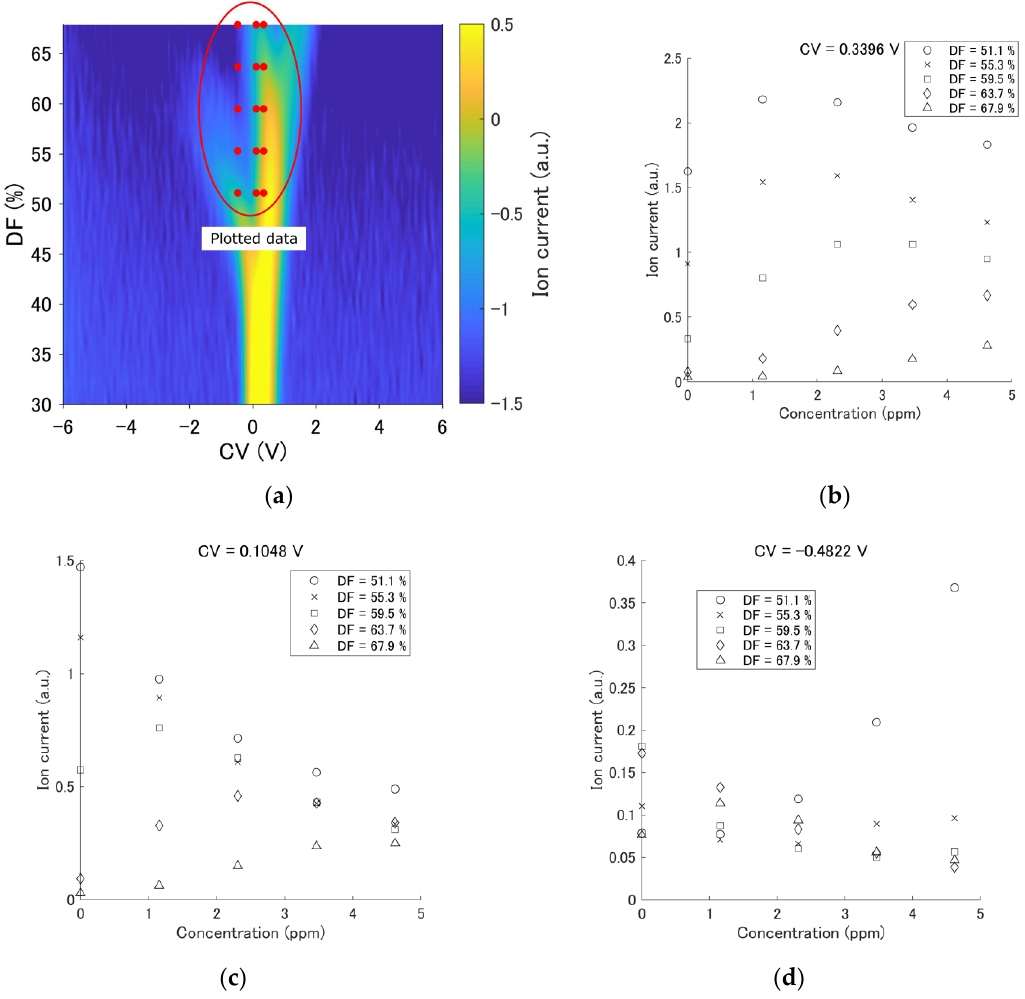
Figure 4. An example of a ternary gas mixture. The concentration of acetone was changed from 0 ppm to 4.6 ppm, and the concentrations of other gases were fixed at 6.1 ppm. DFs of 51.1, 55.3, 59.5, 63.7, and 67.9% were selected. ( a ) The measurement results indicated that the mixture included 4.6 ppm acetone, 6.1 ppm ethanol, and 6.1 ppm diethyl ether. The red circle indicates the portion of plotted data in the graphs. ( b ) The output at CV = 0.3396 V. ( c ) The output at CV = 0.1048 V. ( d ) The output at CV = −0.4822 V.